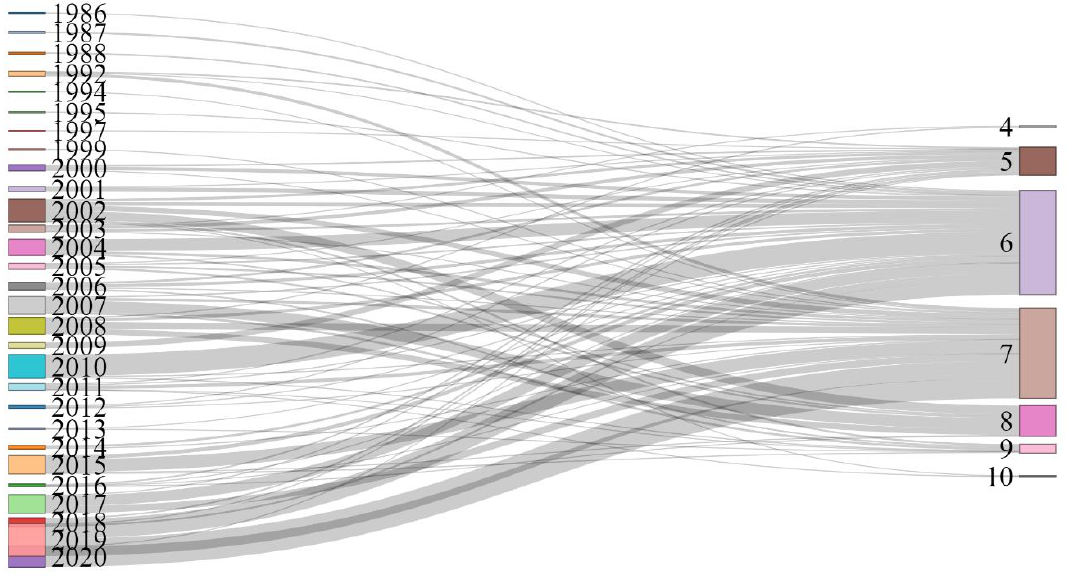
Figure 3. Fire-occurrence monthly